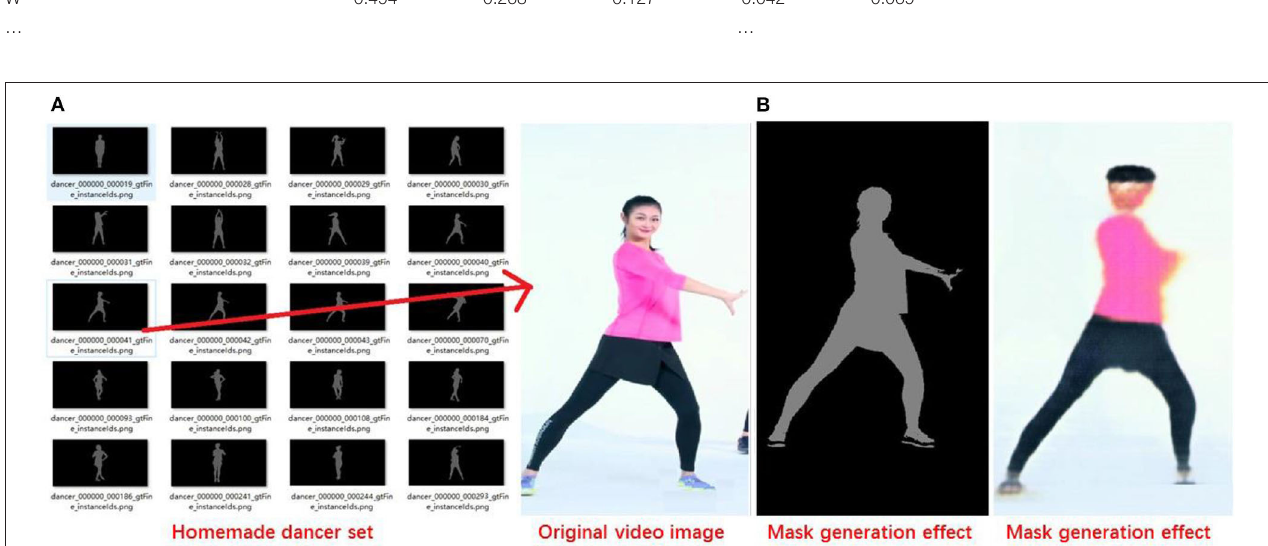
FIGURE 10 | Dance movement generation (A) . Deep learning process (B) . Generation of virtual people.